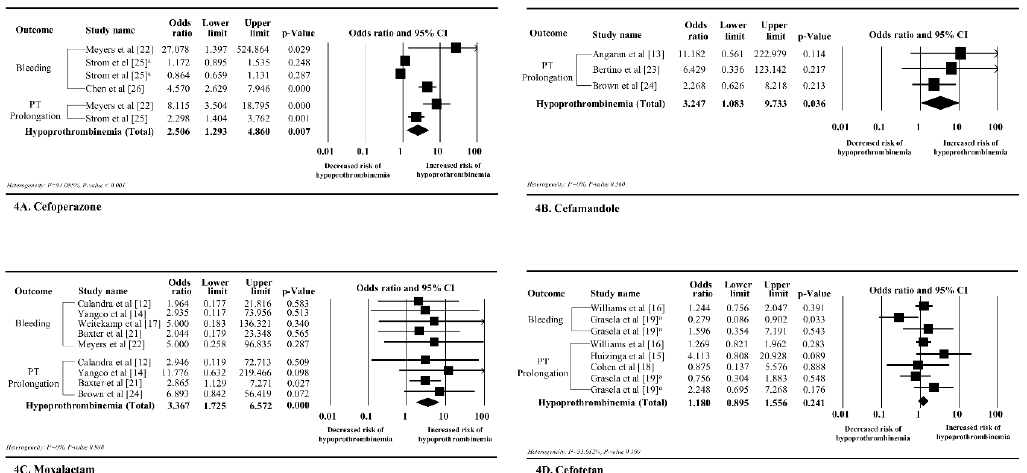
Figure 4. Subgroup analyses of hypoprothrombinemia and each NMTT-cephalosporins. NMTT, N-methylthiotetrazole side chain. a Multiple control groups from the study were treated independently in the meta-analysis.